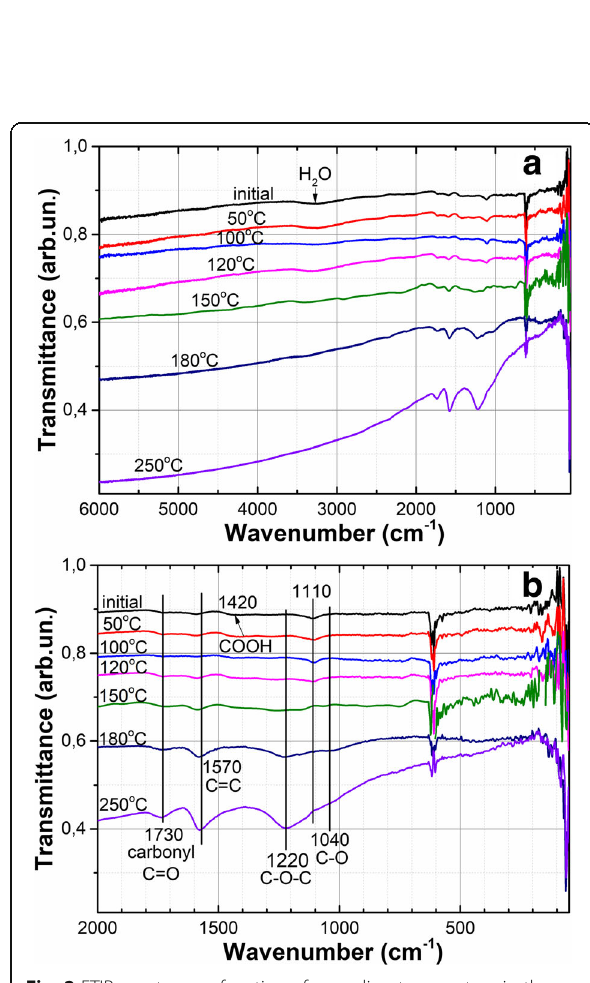
Fig. 2 FTIR spectra as a function of annealing temperature in the range of wave numbers from 100 to 6000 cm − 1 ( a ) and from 100 to 2000 cm − 1 ( b